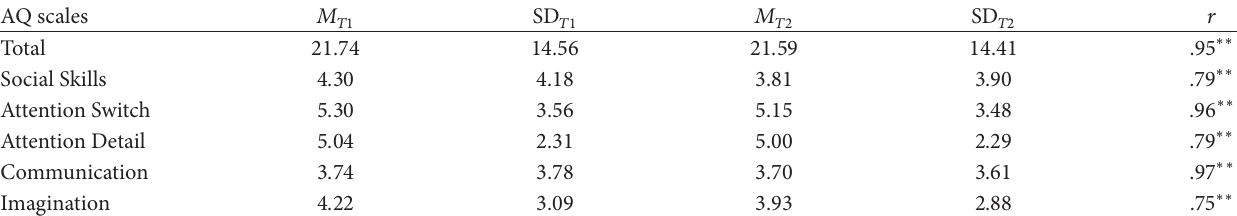
Table 3: Independent samples t -tests, means, standard deviations, and bivariate correlation for the test-retest reliability of the AQ and its subscales for TD ( 𝑛 = 17 ) and ASD ( 𝑛 = 10 ) participants.